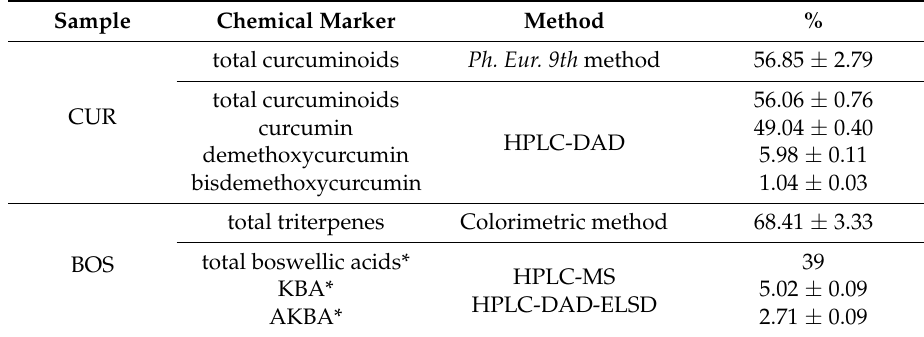
Table 1. Chemical composition of Curcuma longa L. rhizome (CUR) and Boswellia serrata Roxb. gum resin (BOS). *Retrieved from Catanzaro et al.,